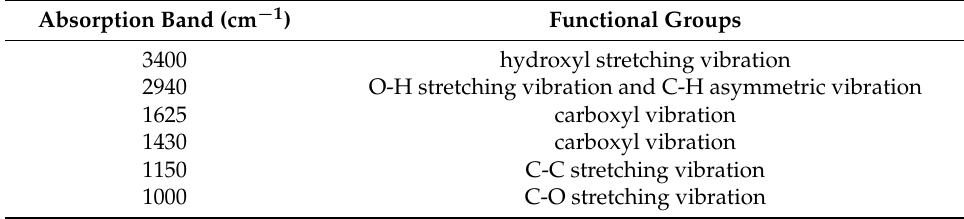
Figure 2. FT-IR spectra of GCP-1 and GCP-2 over the range of 400–4000 cm − 1 . Table 2. FT-IR spectra assignment of polysaccharide functional groups.